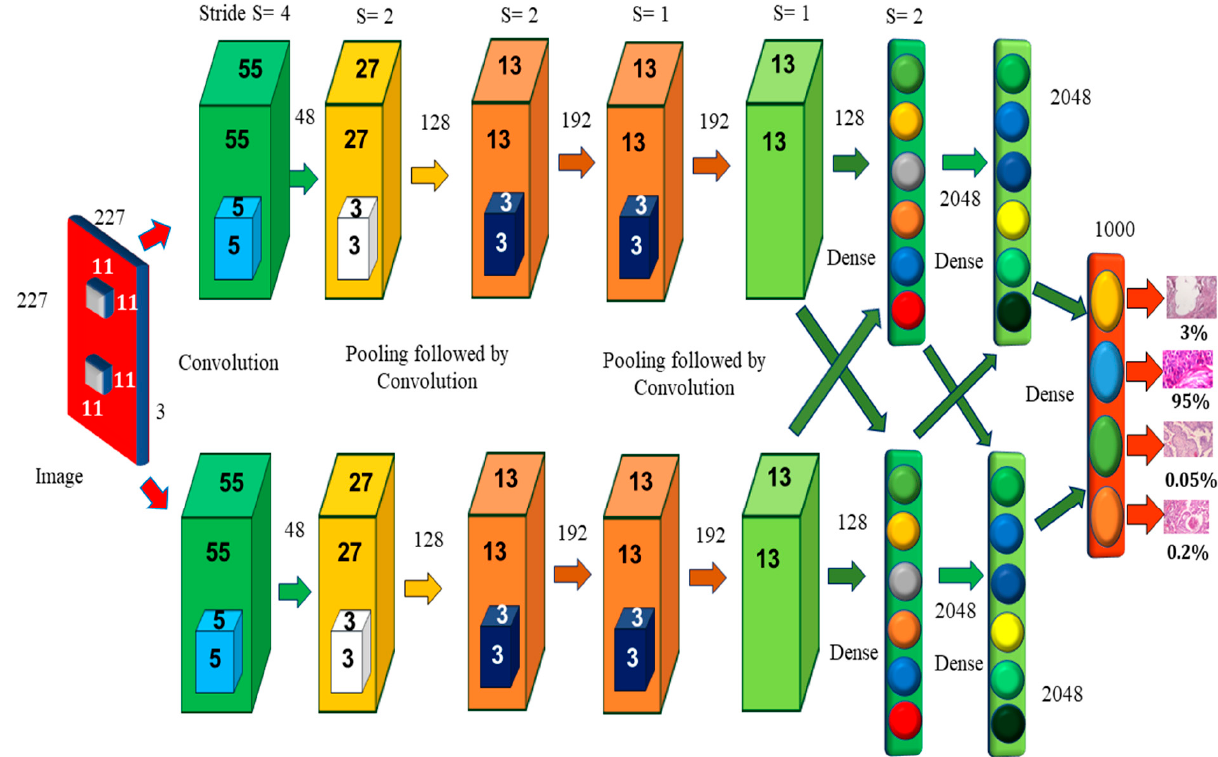
Figure 3. AlexNet Architecture [10].